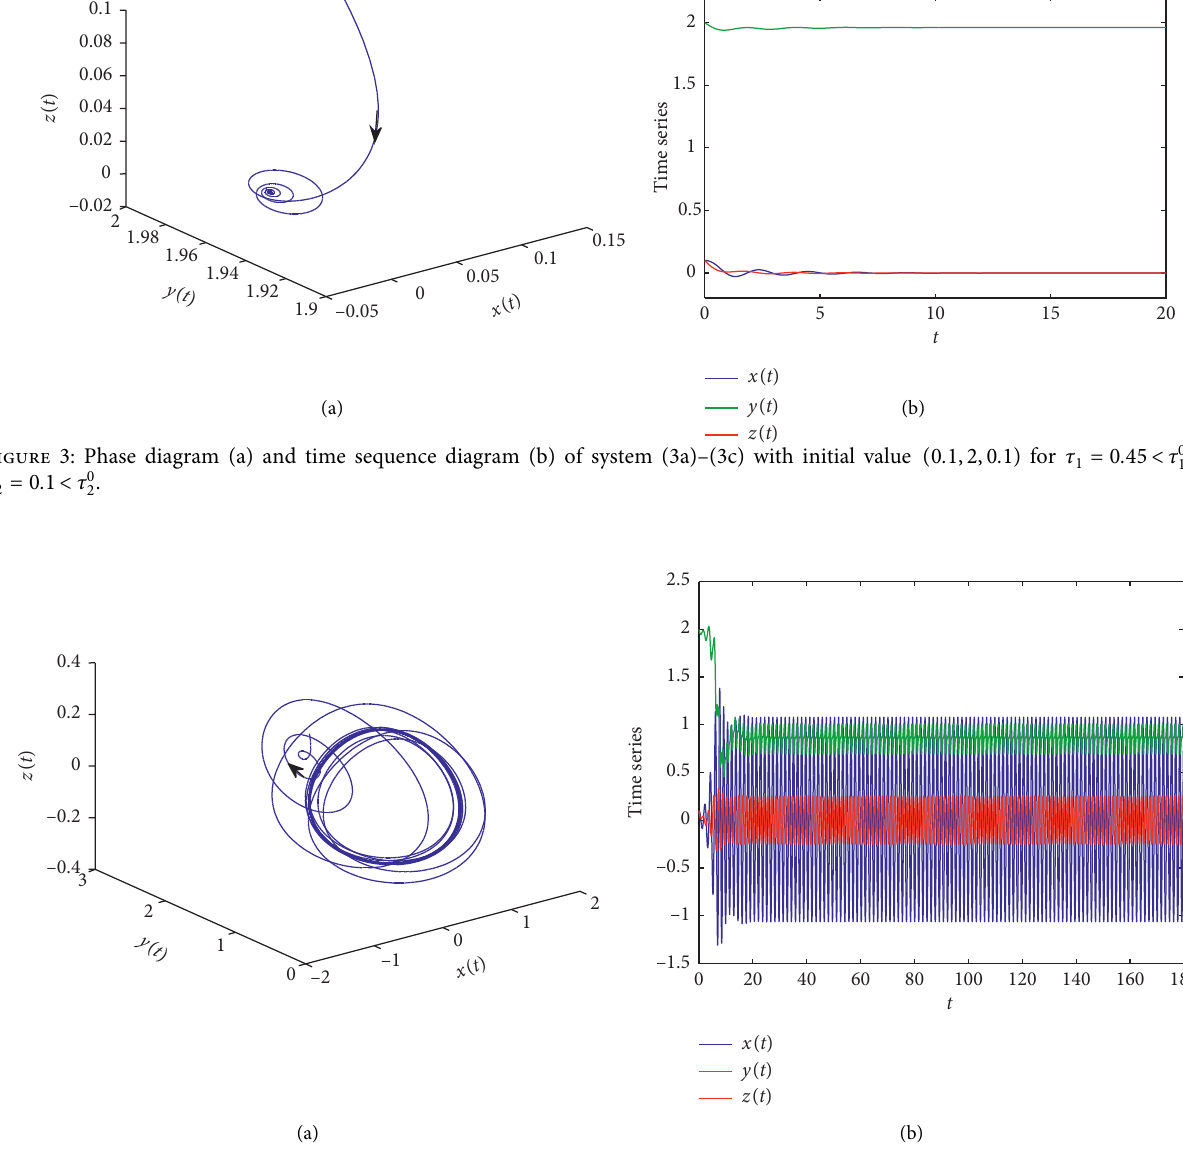
� 0 . 45 < τ 0 � 0 . 1 < τ 0 and τ 1 2 1 2